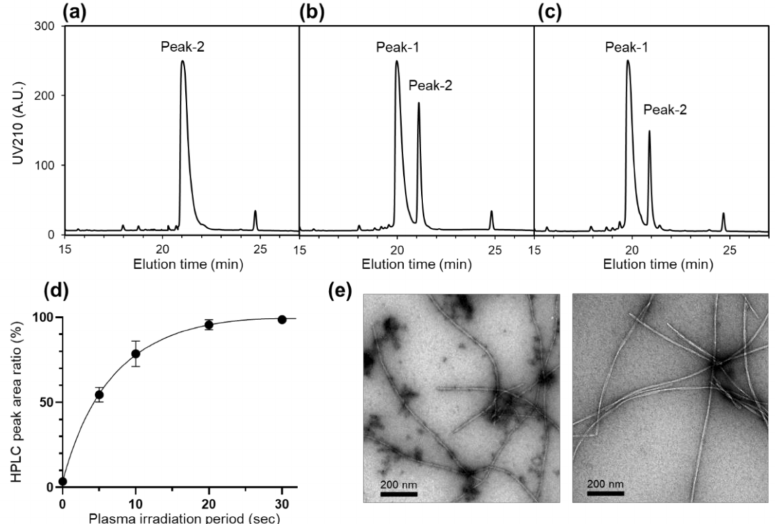
Figure 4. HPLC profiles of ( a ) A β (1–40) without CAP treatment, ( b ) A β (1–40) with 10 s CAP treatment, and ( c ) A β (1–40) dissolved into the buffer solution pretreated with CAP. ( d ) Changes in the HPLC peak area ratio of peak-1 to peak-2 depending on the period of CAP irradiation. Each ratio value is the mean ± SD of three values. ( e ) TEM images of amyloid fibrils prepared by A β (1–40) in peak-1 (left panel) and in peak-2 (right panel)